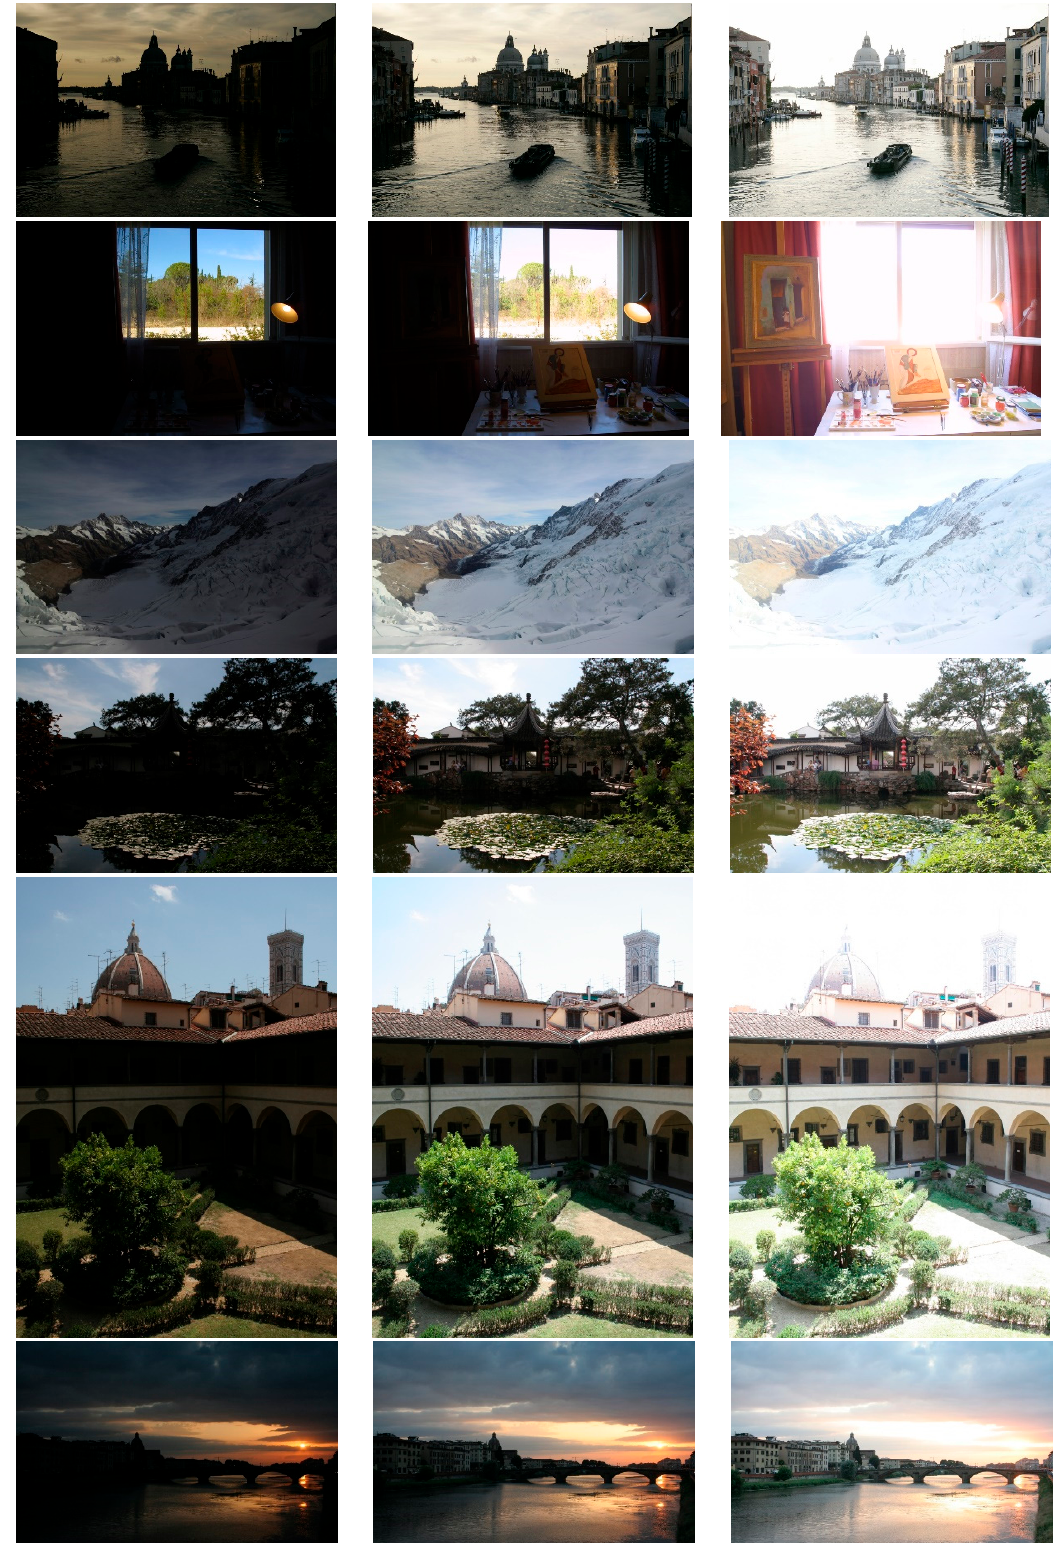
Figure 4. Eight test image sequences. (From top to bottom) Cottage, Masked Lady, Grand Canal, Studio, Mountains, Chinese Garden, Laurentian Library, and Arno River. The left-column, middle-column, and right-column images show the under-exposure, normal-exposure, and over-exposure images, respectively.